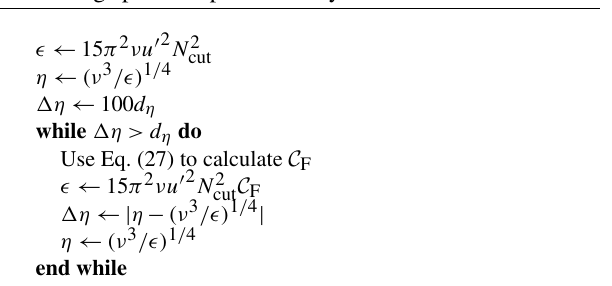
Algorithm 1 Procedure of iterative (cid:15) determination based on missing spectrum part recovery.